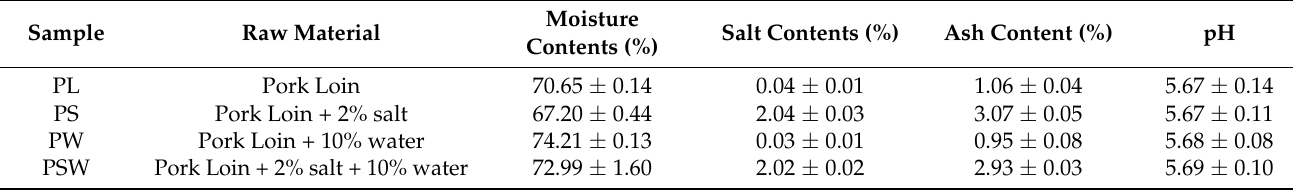
Table 1. Composition and pH of the pork patty